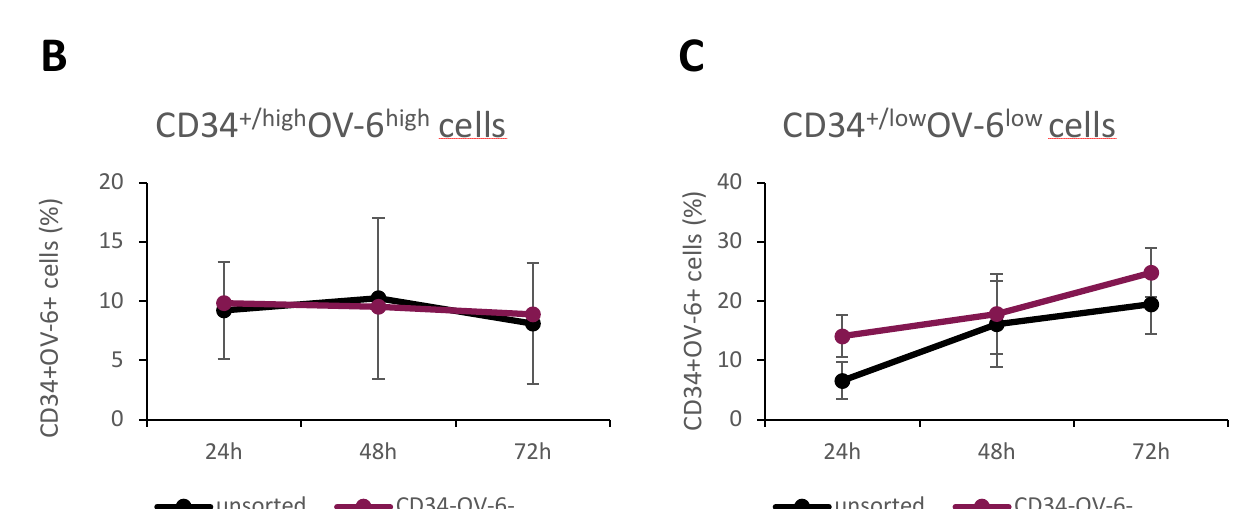
Figure 6. CD34 +/low OV-6 low CD90 + CSCs can derive from CD34 − OV-6 − non-CSCs. ( A ) After 24 h of FACS sorting, CD34 − OV-6 − and unsorted cells were treated with 100 nM decitabine and 2 µ g/mL cisplatin for 24, 48 and 72 h and measured for CD34 expression and OV-6 binding using flow cytometry. These are representative results of 8 experiments. ( B , C ) The values are the means, which are presented with error bars depicting the standard deviation from the mean.